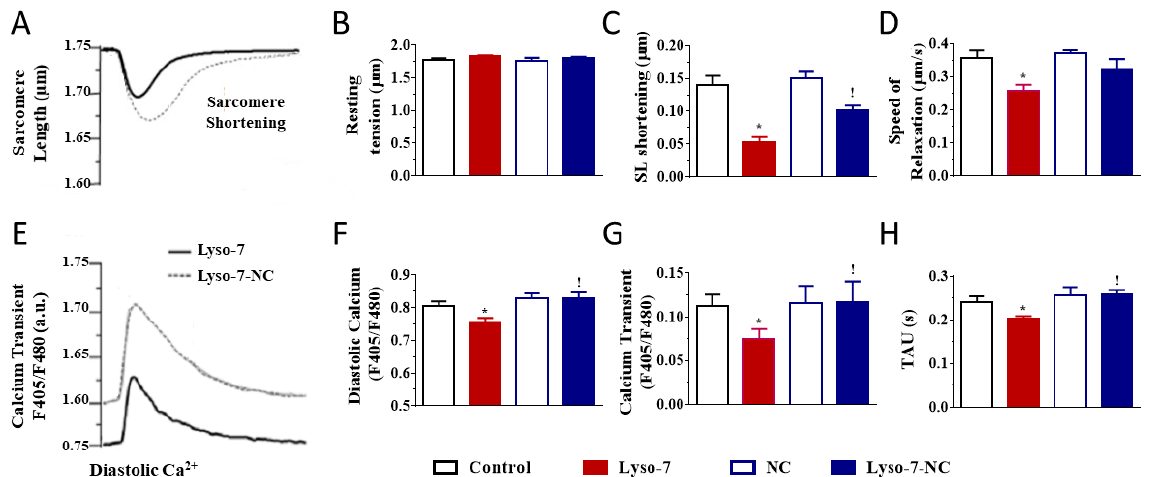
Figure 2. Effect of in vivo administration of Lyso-7 and Lyso-7-NC (1.6 mg/kg, once a day for seven days) on contraction ( A – D ) and Ca 2+ transient ( E – H ) in freshly isolated cardiomyocytes. Typical recordings of the effects of Lyso-7 (free form) and Lyso-7-NC on sarcomere length (SL) shortening ( A ) and Ca 2+ transient ( E ), both under field stimulation at 1 Hz. ( B – D ): averaged data of resting SL, SL shortening and relaxation, respectively, and ( F – H ): averaged data of diastolic Ca 2+ , Ca 2+ transient and decay of Ca 2+ transient (Tau), respectively, all for the four experimental groups (Control, Lyso-7, NC, and Lyso-7-NC). ANOVA followed by Tukey post-test ( p < 0.05). * Lyso-7 vs. Control; ! Lyso-7-NC vs. Lyso-7 . n = 4; n = 12–18.